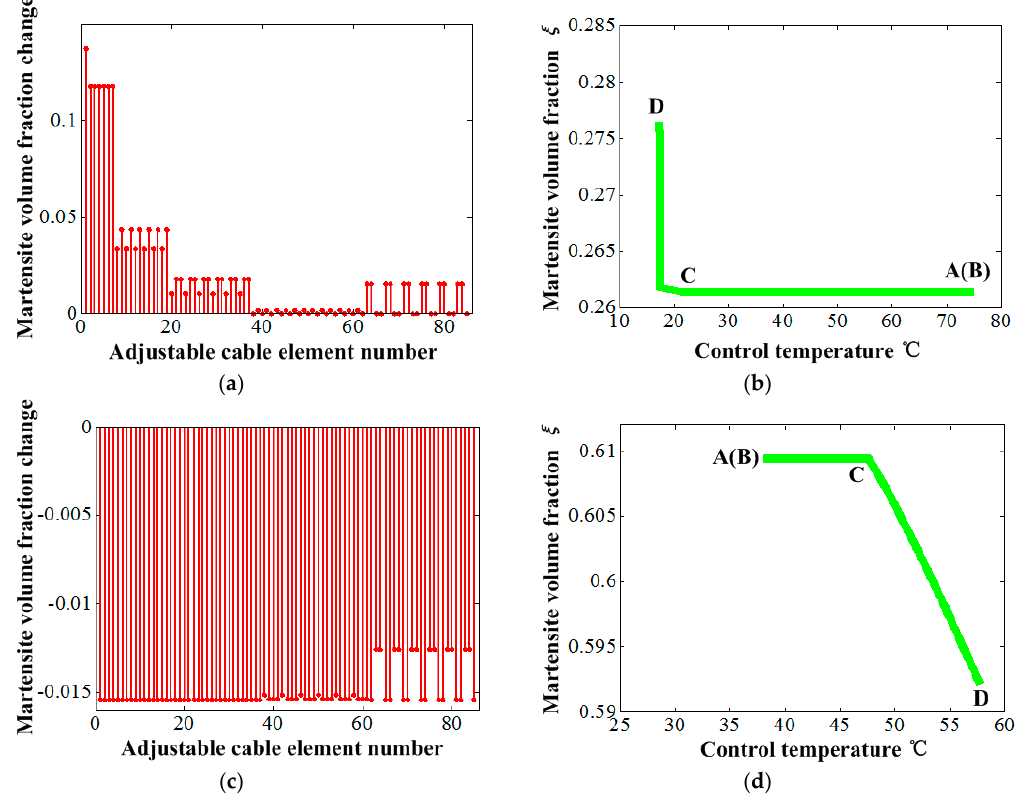
Figure 9. The martensite volume fraction change under the control temperature: ( a ) Variations of all elements of vertical cables under environment temperature 140 °C, ( b ) single element change under environment temperature 140 °C, ( c ) variations of all elements of vertical cables under environment temperature − 100 °C and ( d ) single element change under environment temperature − 100 °C.